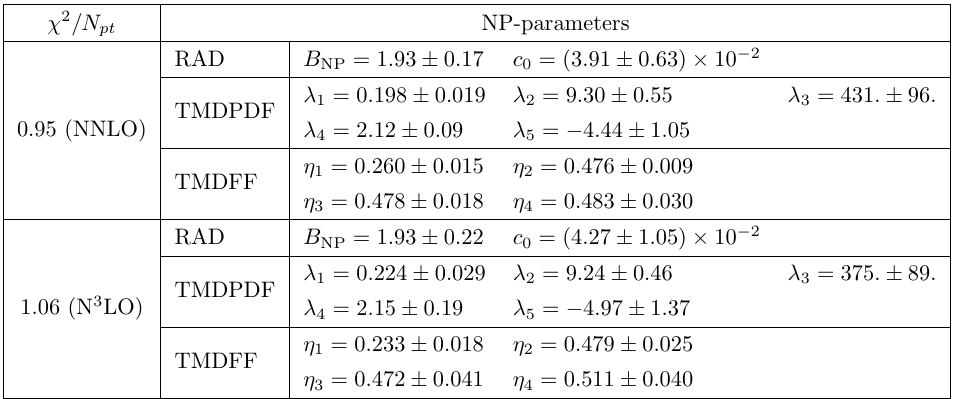
Table 9 . Values of (cid:31) 2 and NP parameters obtained in the global (cid:12)t of DY and SIDIS data. The collinear distributions are NNPDF31 and